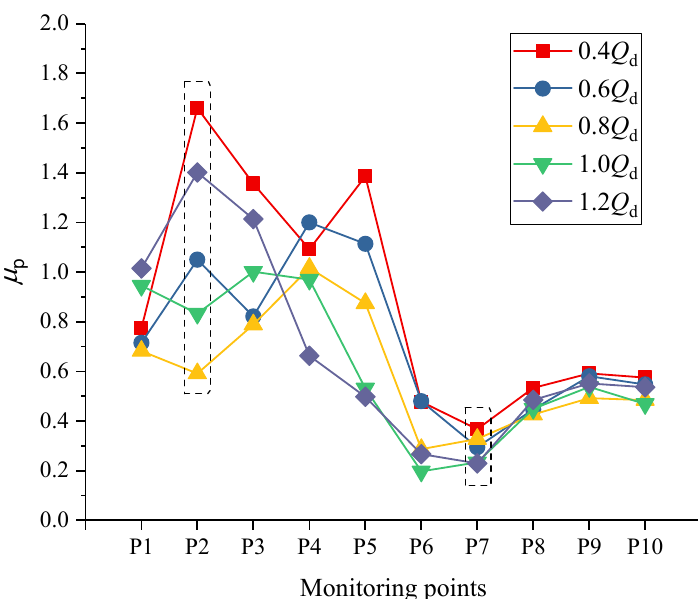
Figure 8. Intensity of pressure pulsation of different monitoring points in volute. At 0.4 Q d , the change of pressure near the tongue area (P2) was the most significant (shown in Figure 9a). As the relative gap between the impeller outlet and the volute wall surface increases, the intensity of rotor ‐ stator interference weakens, and the influence of the flow rate on the pressure pulsation decreases. For the P4–P6 monitoring points, the pressure pulsation amplitude of different flow rates is getting smaller (shown in Figure 8). For the P7 monitoring point, the pressure pulsation amplitude achieves the minimum value (shown in Figure 8), and the changes in flow rate have a slight effect on pressure pulsation (shown in Figure 9b). In Figure 9, the data were captured from the last two ro ‐ tation cycles of impeller, and the time required for one rotation cycle ( T ) is about 0.02 s. There are two main peaks and valleys in one rotation cycle that is directly linked to the number of blades ( z = 2). At the same time, this also shows that the rotor ‐ stator interfer ‐ ence between the pump’s dynamic part (impeller) and static part (volute) was the main source of pressure pulsation at each monitoring point.